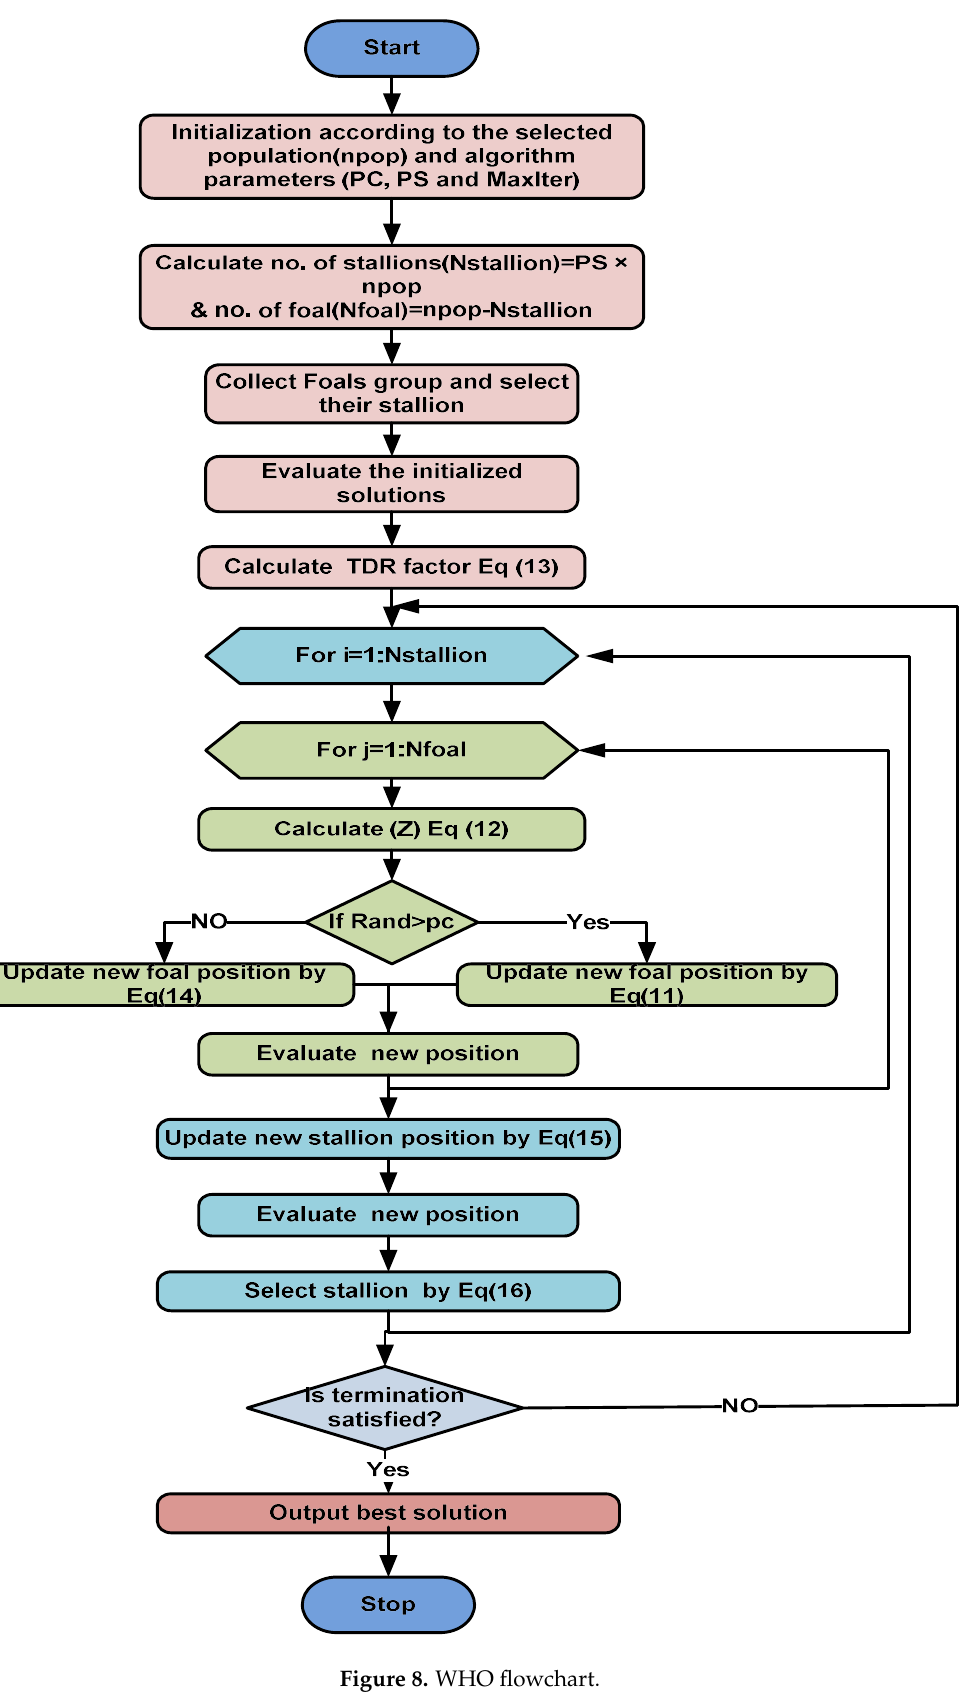
Figure 8. WHO flowchart.